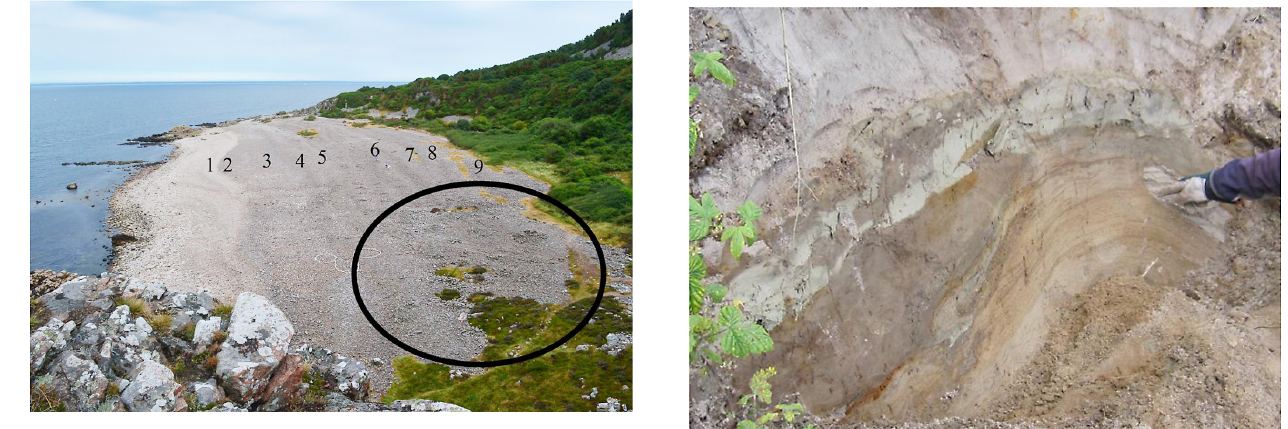
Fig. 5. Numbered beach ridges on Hallandsaasen seen from above. A major earth slide in the ringed area in the lower right side of the picture covers the older beach ridges (6–9) but not the younger ones (1–5). The view as seen during the field trip. The photograph is taken by the Russian seismologist Olga Pavlenko. Numbering is from Mörner (2003).